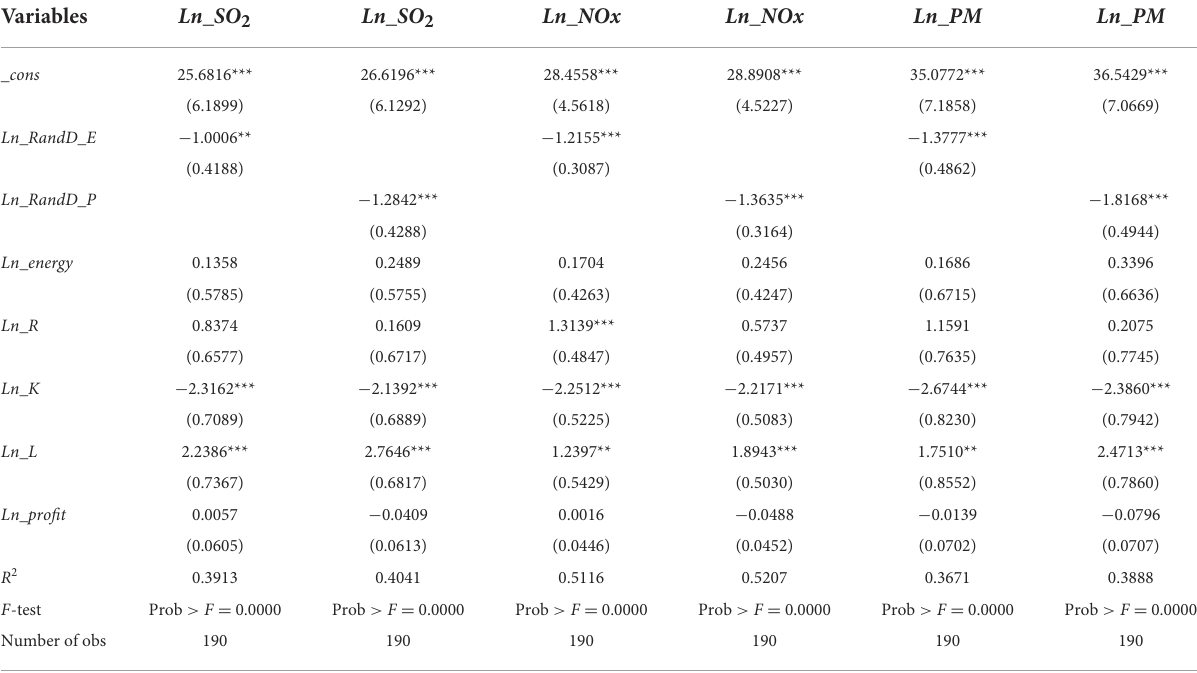
TABLE 3 Nexus between research and development (RandD) activities and industrial waste gases.